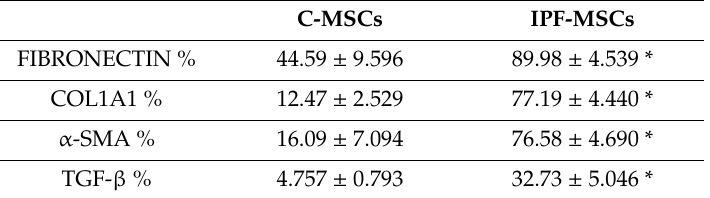
Table 1. Quantification of the protein